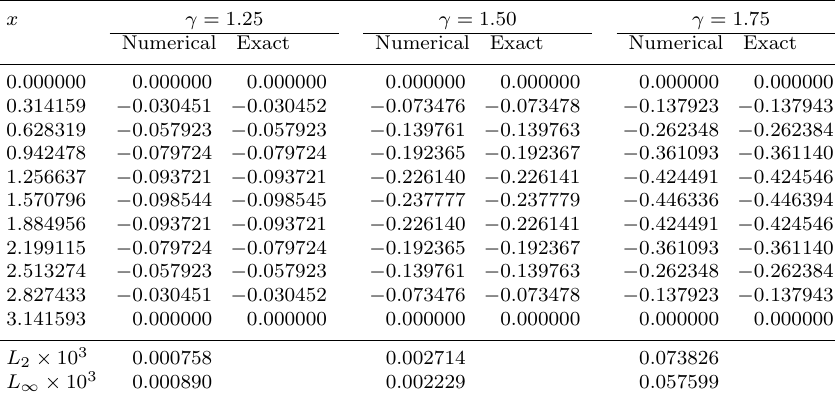
Figure 2. Numerical solutions of the fractional diffusion–wave problem: a) u ( π /2 ,t ) for ∆t = 0 . 0015 and M = 40 at different time levels, b) for γ = 1 . 50 and M = 40 at different time levels. Table 5. The comparison of solutions and error norms of the diffusion-wave problem for M = 40, ∆t = 0 . 0015 and t f = 3 . 75.